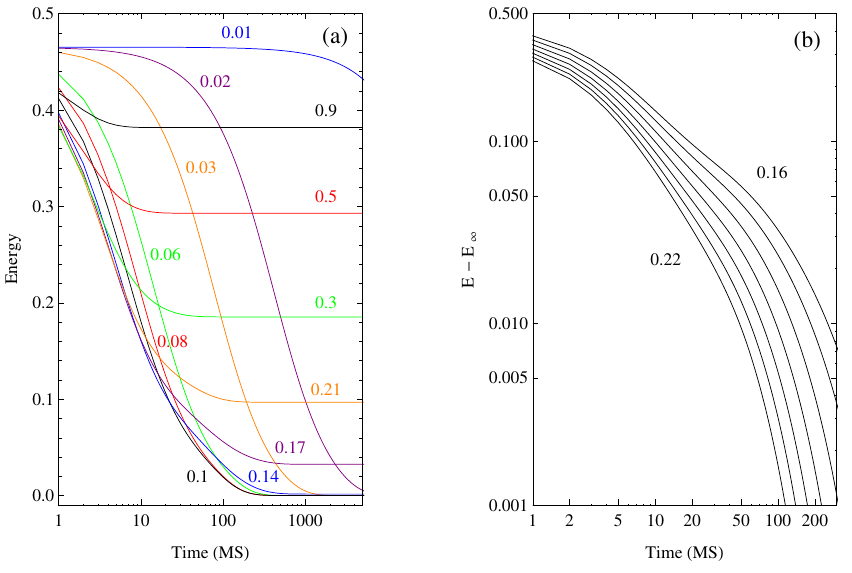
Figure 4. Energy relaxation of the open region. ( a ) evolution at the whole range of temperatures; ( b ) evolution of energy towards its equilibrium value (E − E ∞ ) at temperatures between T = 0.16 and T = 0.22, every 0.01 T units, shown with more detail at the double-logarithmic